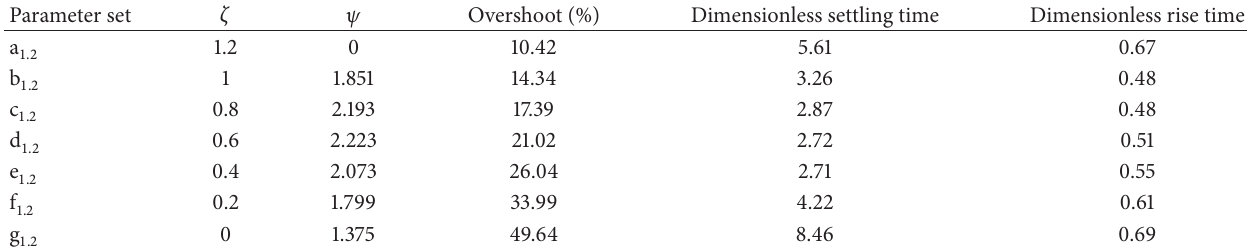
Table 1: 𝜁 - 𝜓 combinations with dimensionless settling energy equivalent to the pure PD control with 𝜁 = 1.2 .